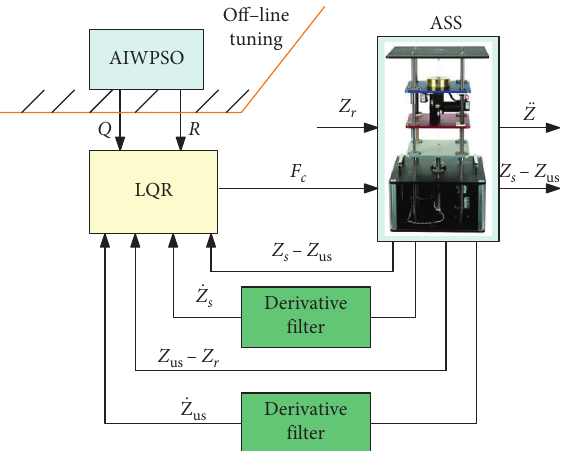
Figure 5: Proposed AIWPSO-tuned LQR for quarter-car